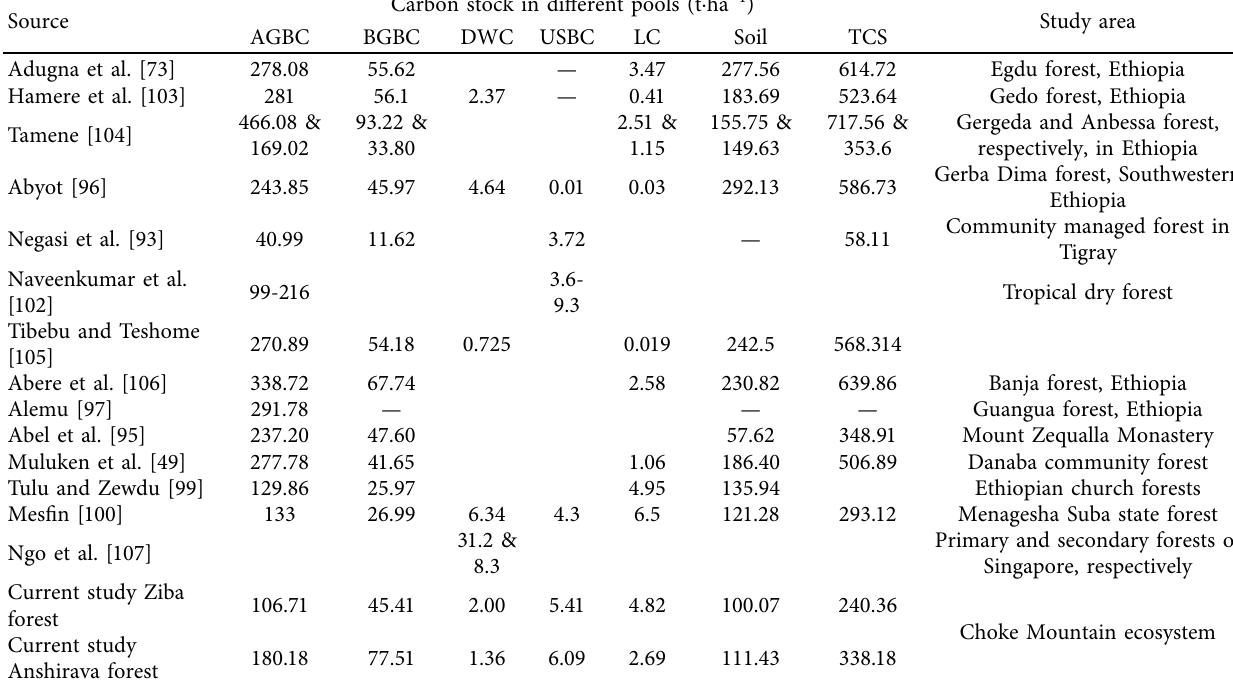
Table 15: Comparison of carbon stock with previous